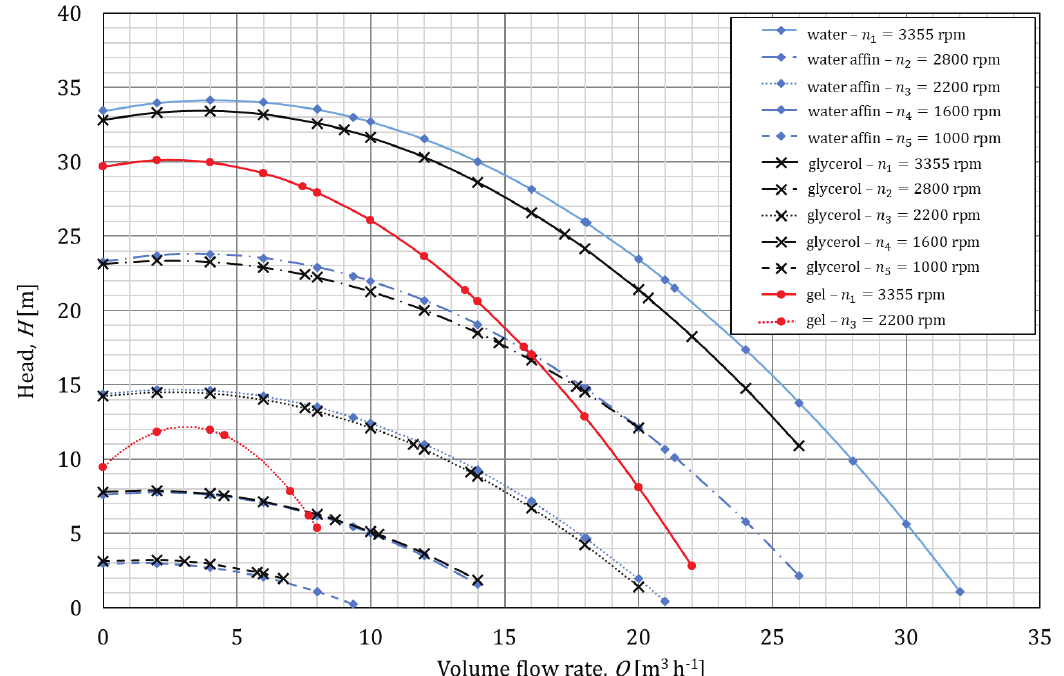
Fig. 3 – Performance curves of the pump: measured at nominal speed and calculated with affinity-law for other rotational speeds with water (blue ◊); measured with glycerol (black ×) at five rotational speeds, and with gel (red ●) at two rotational